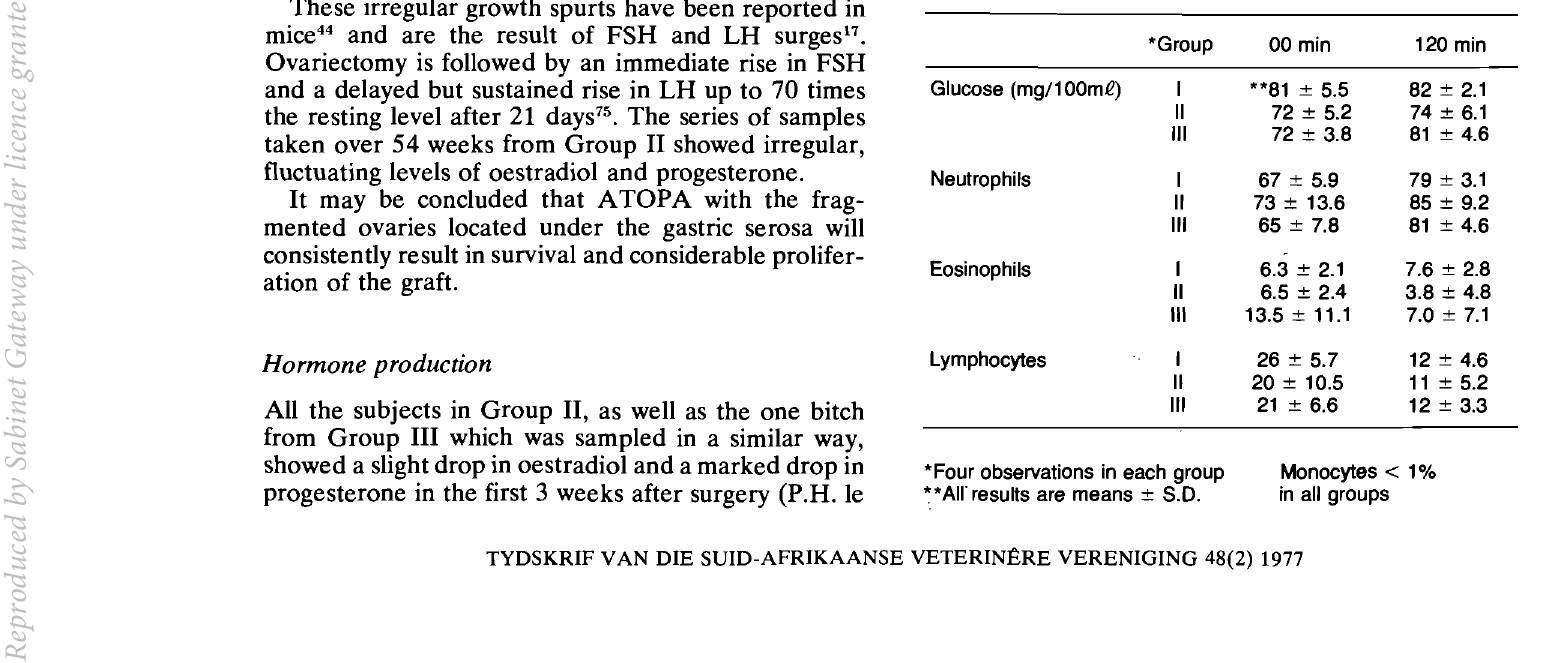
Table 3: GLUCOSE AND DIFF.